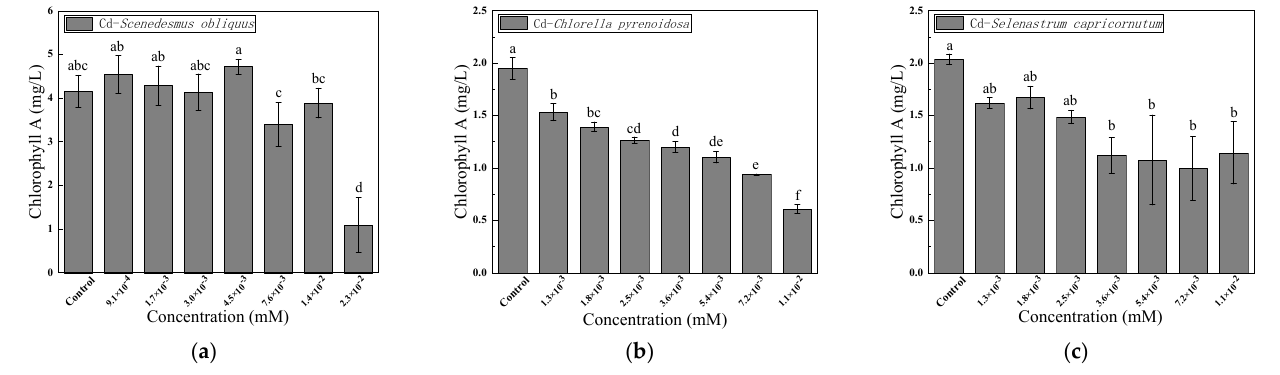
Figure 2. Effects of 96-h Cd exposure on the content of chlorophyll a in S. obliquus ( a ), C. pyrenoidosa ( b ), and S. capricornutum ( c ). The different letters: a, b, c, d, e, and f in the figure indicated that significant differences ( p < 0.05).